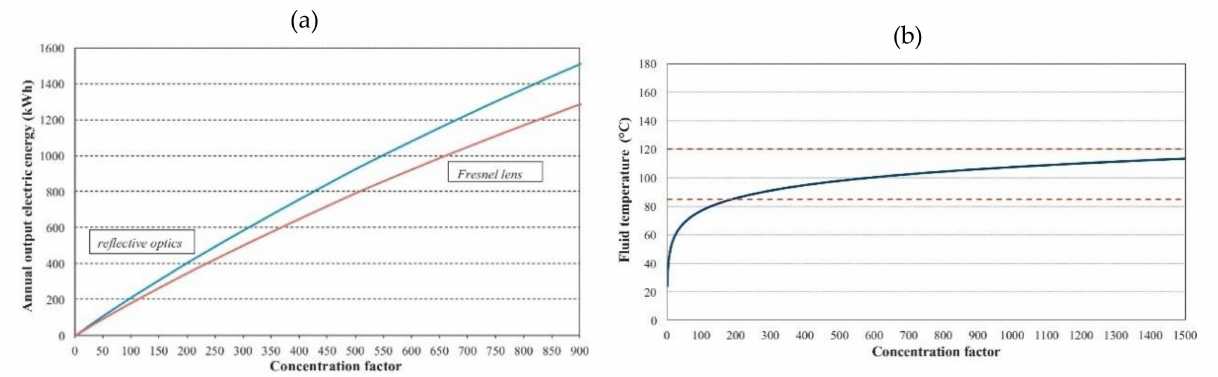
Figure 31. ( a ) Electrical energy output from two types of lenses; ( b ) fluid temperature with changing concentration factor (reprinted from [133], with permission from